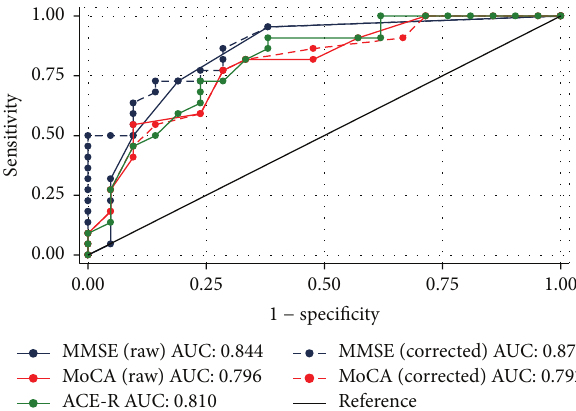
Figure 2: Receiver-operator characteristics (ROC) curves for the three screening tests (raw and corrected